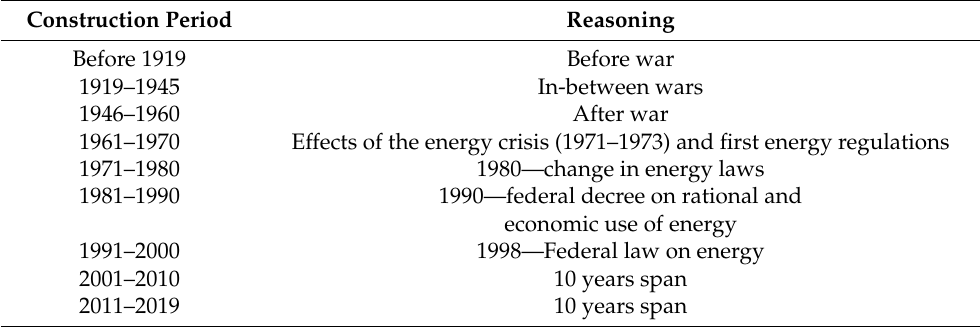
Table 1. Definition of construction periods